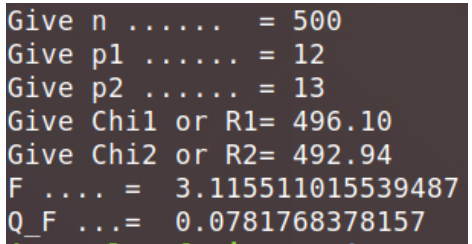
Fig. A1.— Application example of fisher.py